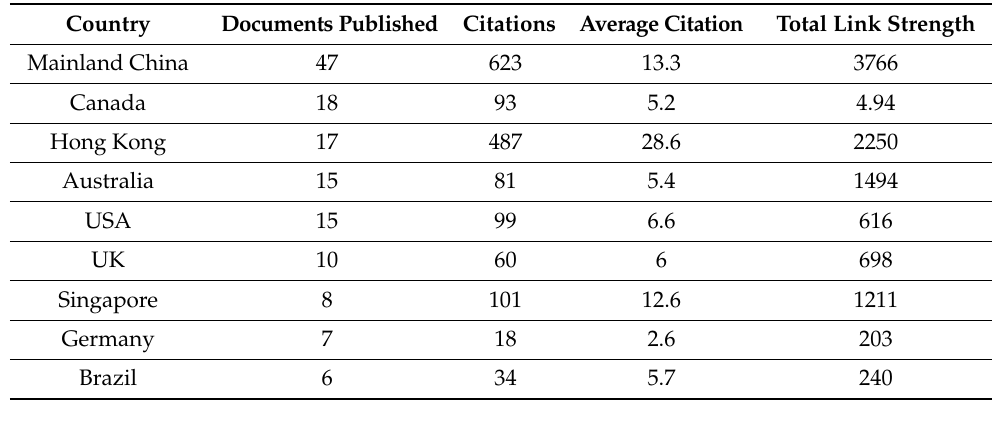
Table 9. Adoption of OSC initiatives based on the number of documents and citations in the top nine countries. The numbers indicate the number of citations per country [26].